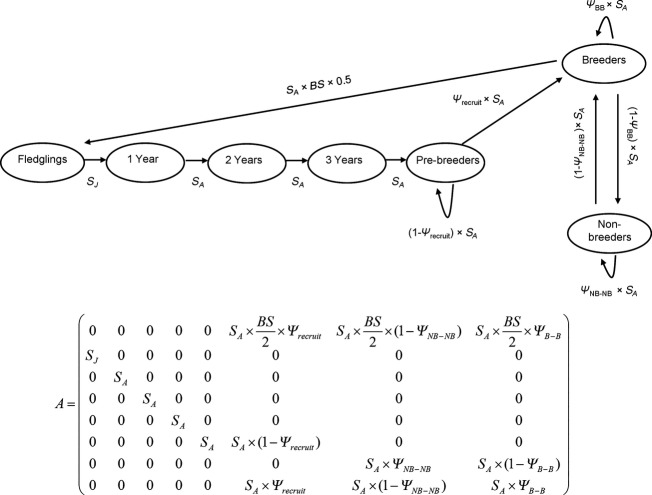
Hypothetical life cycle of the Antarctic petrel. The population matrix A contains the vital rates and projects the population from time t to t + 1. BS represents the average breeding success calculated as the probability that the egg survives from laying to fledging. SA represents adult survival (survival from 1 year of age onwards) and SJ the average annual survival of juvenile between fledging and 1 year of age. Symbol Ψ represents transition probabilities between breeding status “breeder” (B) and “nonbreeder” (NB); Ψrecruit represents the probability to breed for the first time.